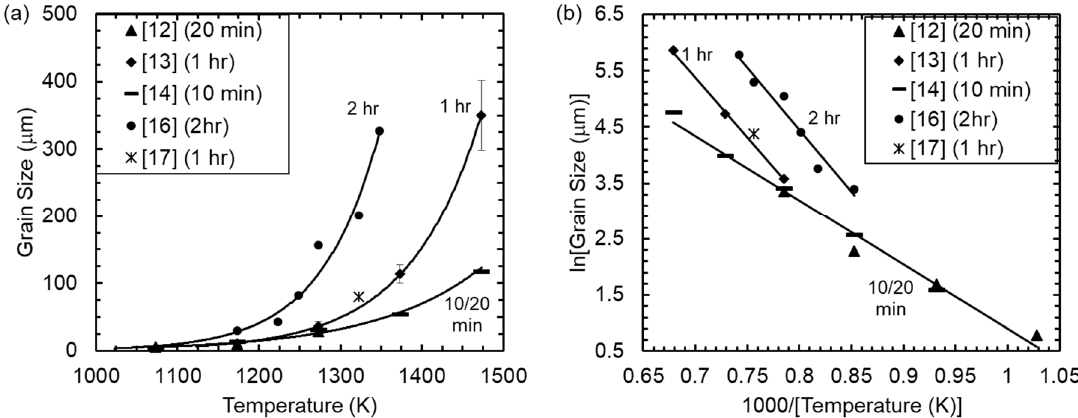
Figure 1. Grain size as a function of solution treatment temperature from references [12–14,16,17] shown as ( a ) a direct relationship and ( b ) an Arrhenius relationship.